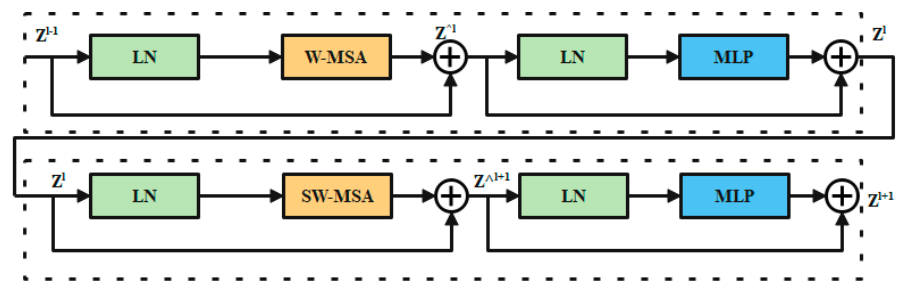
Figure 4. Swin transformer